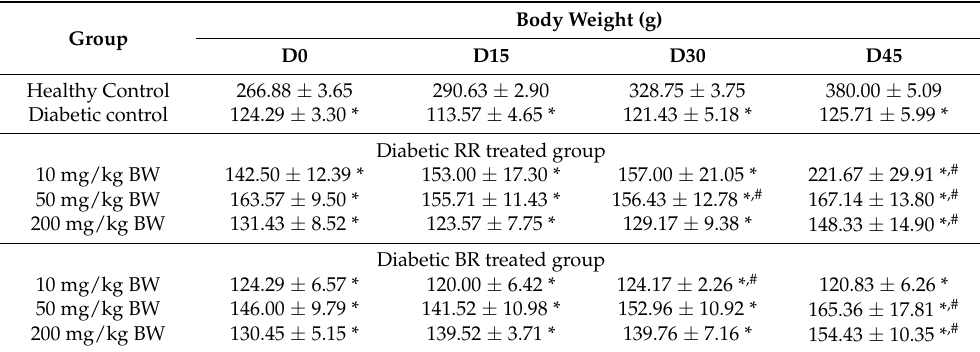
Table 2. The effects of various doses of RR and BR on STZ-induced diabetic rats body weight. Group